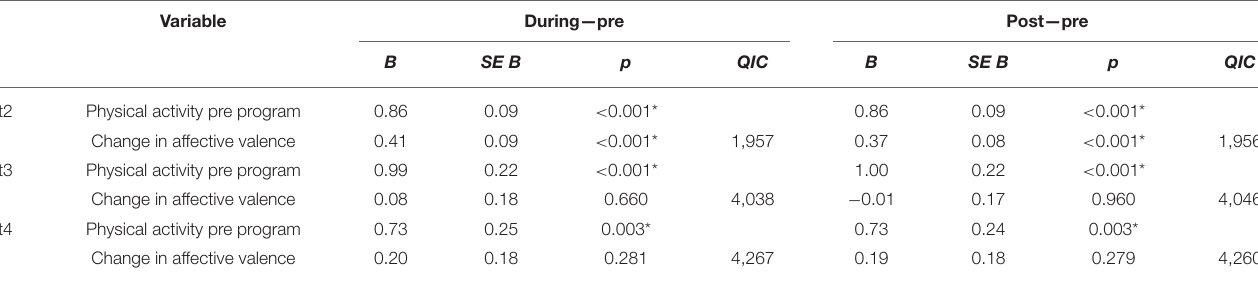
TABLE 2 | Generalized estimating equations with the outcome physical activity post program (t2), at follow-up 3 months post program (t3), and at follow-up 6 months post program (t4) separately for pre-during and pre-post changes in affective valence. Variable During—pre